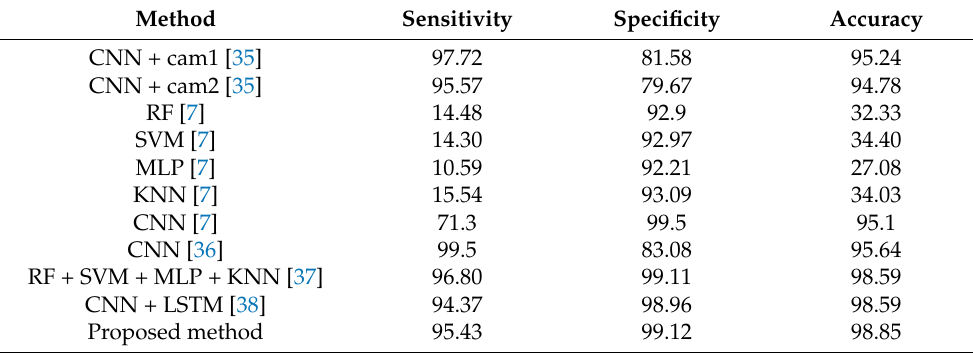
Table 2. Comparison of methods on the UP-Fall detection dataset (%).